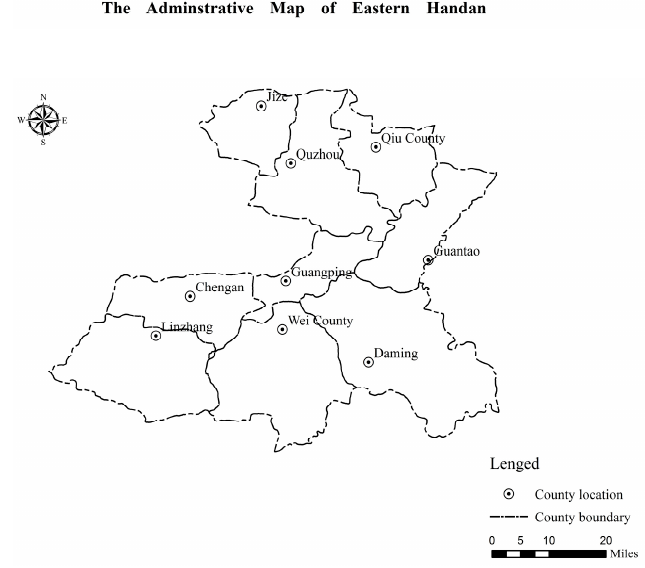
Figure 1. The administrative map of eastern Handan.